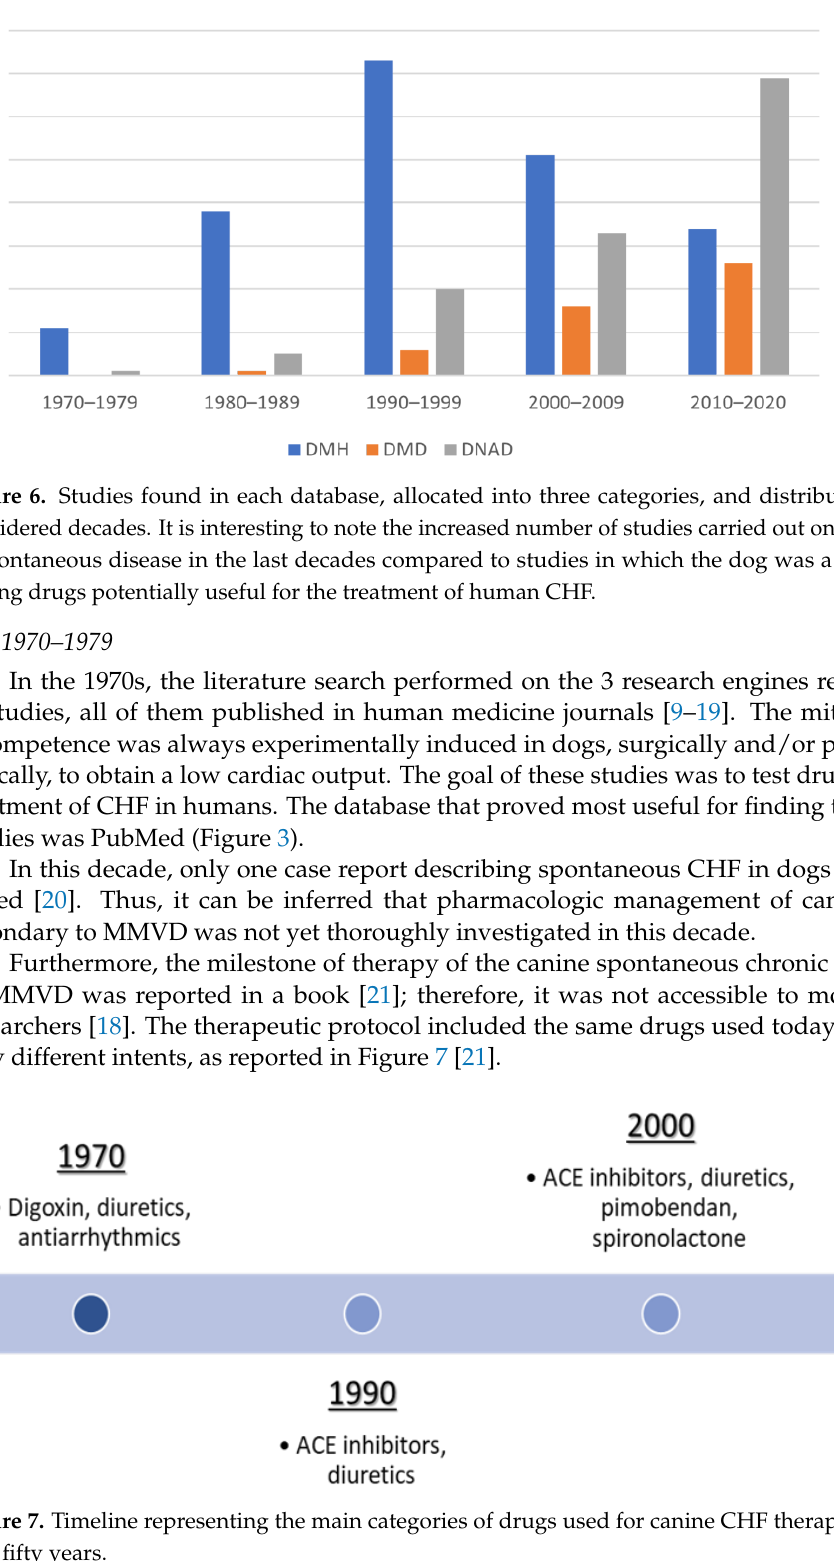
Figure 7. Timeline representing the main categories of drugs used for canine CHF therapy over the past fifty years.